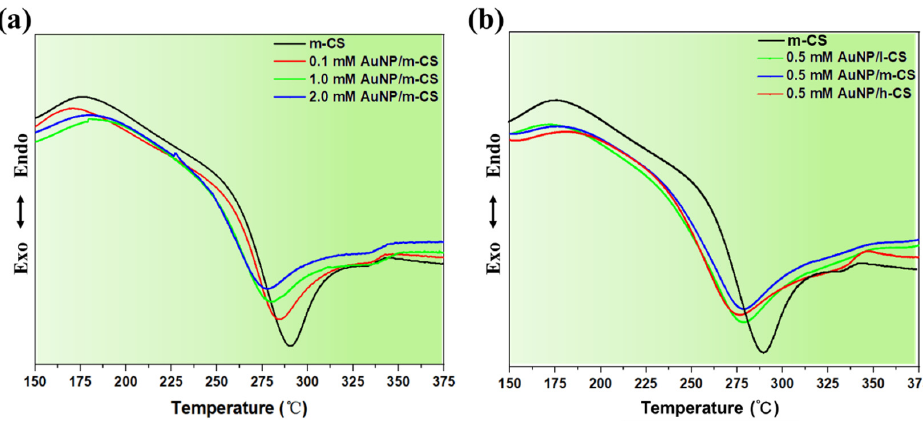
Figure 5. ( a ) DSC curves of m-CS, 0.1 mM AuNP/m-CS, 1.0 mM AuNP/m-CS, and 2.0 mM AuNP/m-CS films. ( b ) DSC curves of m-CS, 0.5 mM AuNP/l-CS, 0.5 mM AuNP/m-CS, and 0.5 mM AuNP/h-CS films.